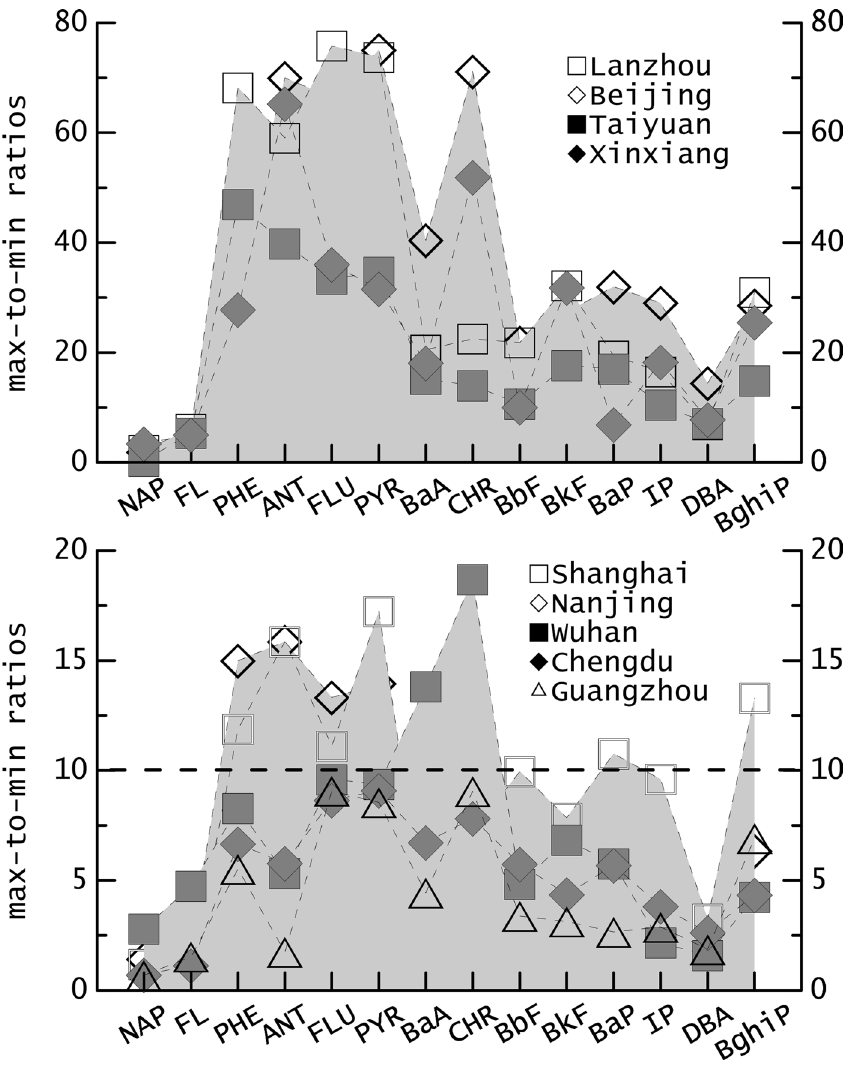
Figure 3. Variations between winter and summer in the concentrations of individual parent PAHs (indicated by max-to-min ratio) in PM2.5 at 9 urban